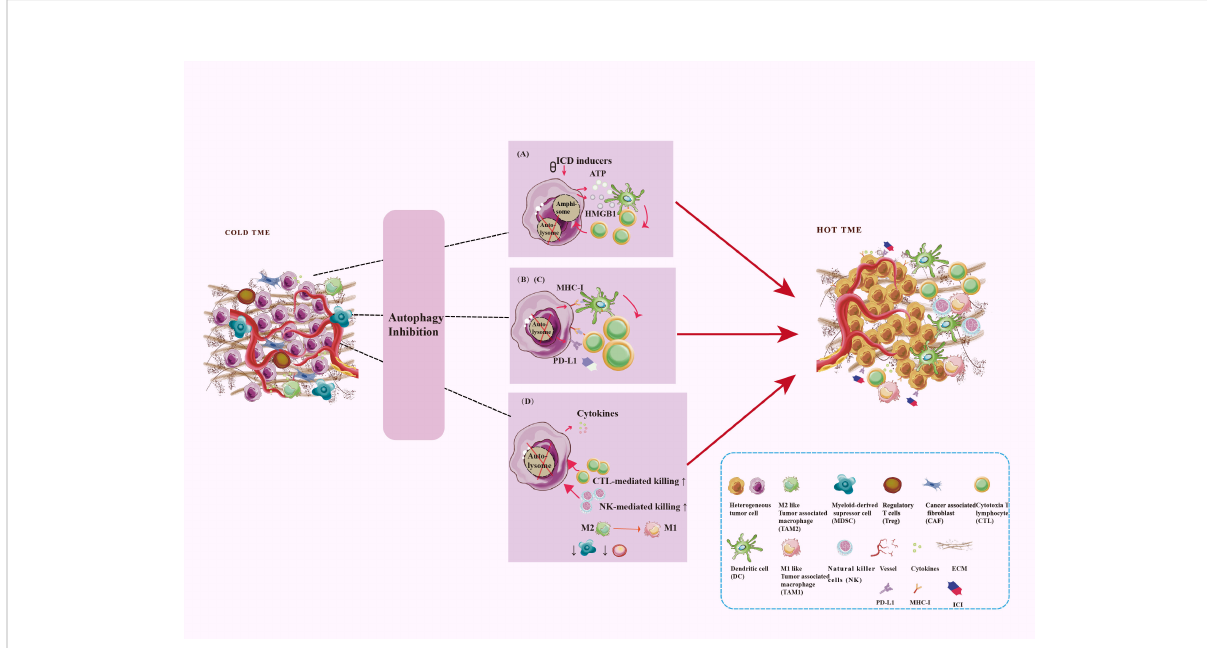
FIGURE 4 Targeting autophagy burns the cold TME. TME regulation mechanism includes antigen signal release, antigen presentation, antigen recognization, as well as immune cell in fi ltration. Autophagy plays a key role in these processes. (A) Secretory autophagy promotes ICD to burn the cold TME. (B) Autophagy inhibits the MHC-I expression on the surface of tumor cells and DC to inhibit antigen presentation. (C) Autophagy inhibits PD-L1 expression on the surfaces of tumor cells. (D) Autophagy inhibits CD8 + T cells and NK cells in fi ltration and tumor-killing effect and promotes the survival and development of Treg and MDSC. Autophagy promotes TAM polarize to M2 and enhances the immunosuppressive function of